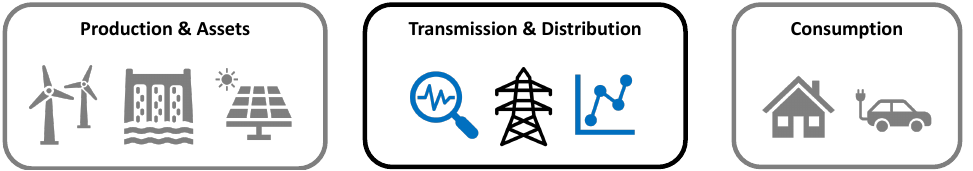
Figure 1. Illustration of the scope of the paper. The figure shows the entire value chain of electricity (from left to right—generation, distribution, and consumption). Machine learning techniques are relevant in all links of the chain (see also our literature overview). Our focus (highlighted in blue and black) is on the background state of the grid at transmission and distribution voltage